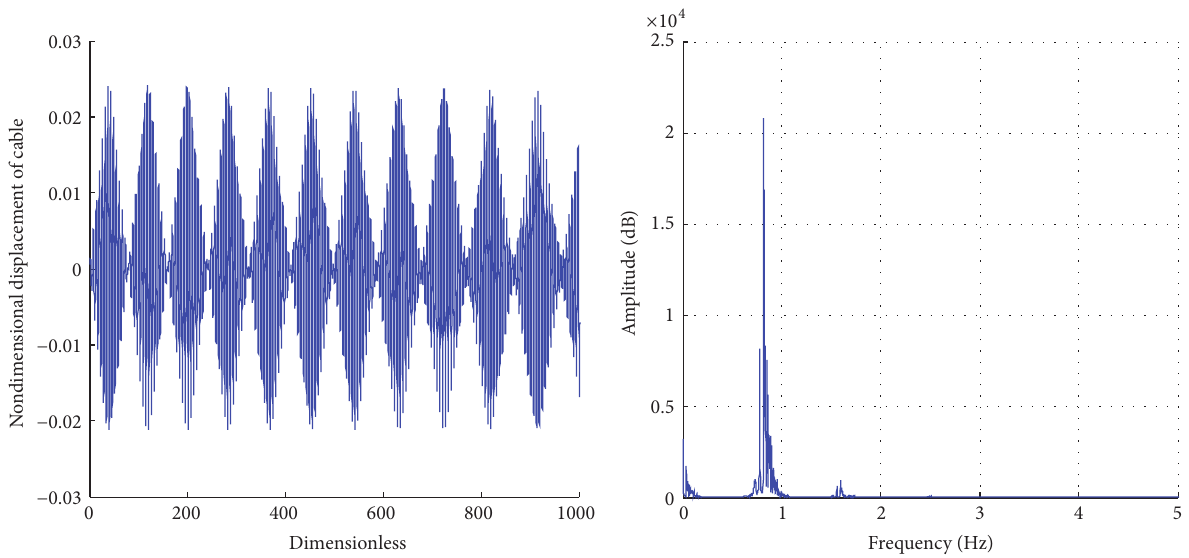
Figure 4: Dimensionless displacement response time history and amplitude-frequency characteristic curve of the cable midspan.